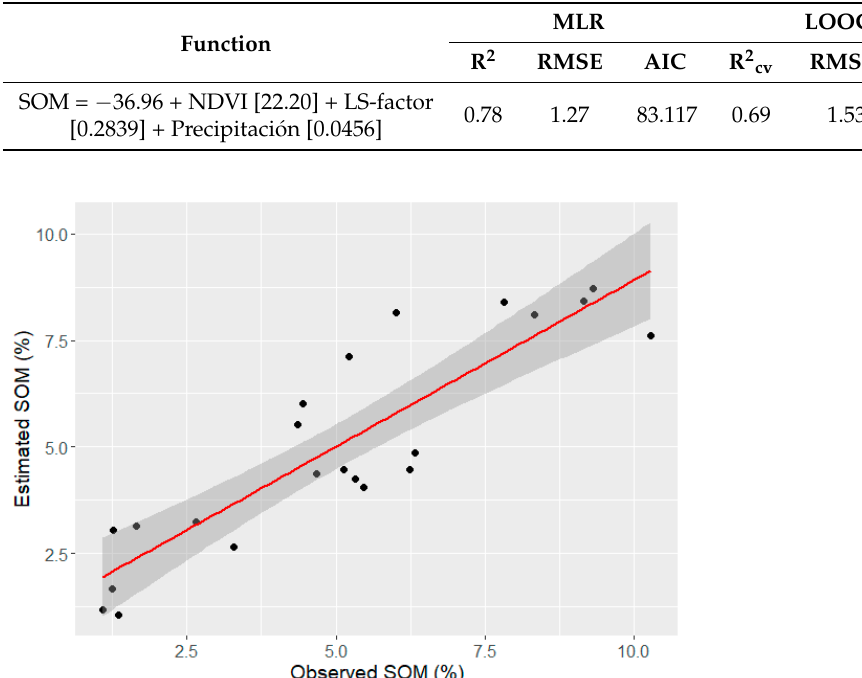
Figure 3. Correlation analysis between SOM and environmental variables. * Correlation is significant at the 0.05 level. Table 5. Performance of the MLR model and LOOCV for SOM.